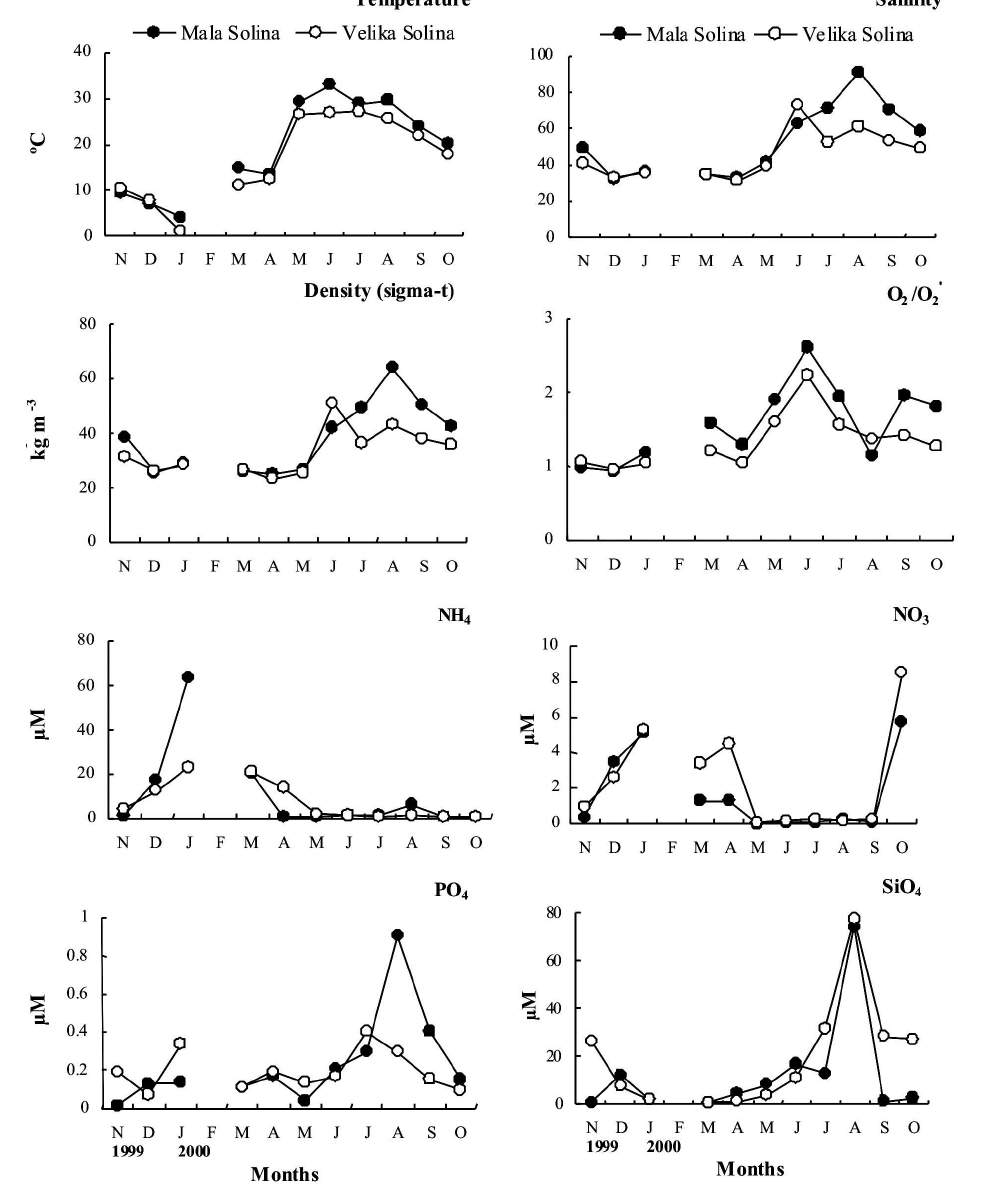
Fig . 2. – Monthly distribution of physical-chemical parameters in Mala Solina and Velika